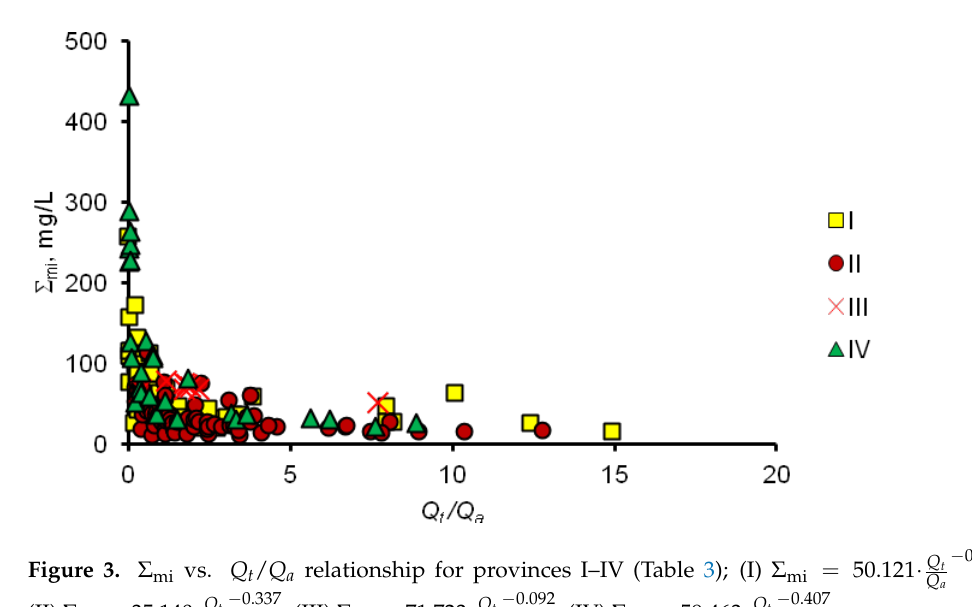
− 0.337 ; (III) Σ mi = 71.723 · Q t Q a